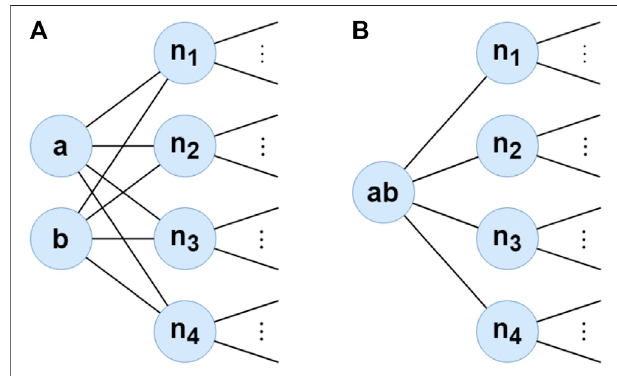
FIGURE 2 | Example of graph compressing. (a,b) are merged into super-node ab connected to the neighbors of both (a,b) .